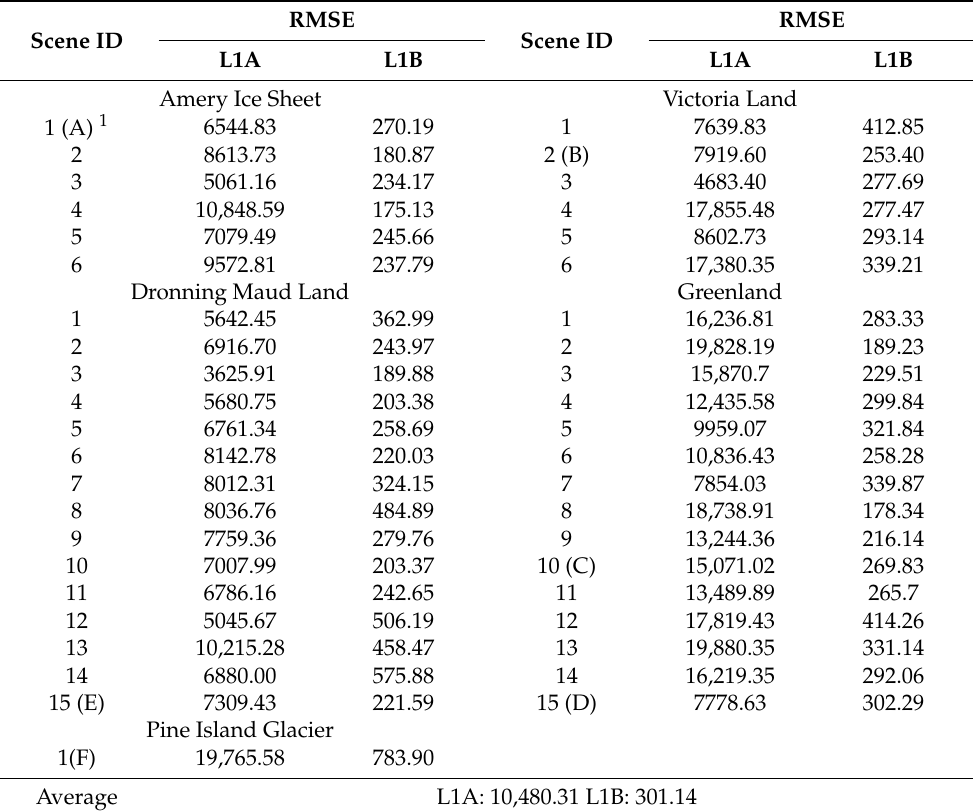
Table 1. Geolocation errors of the BNU-1 L1A/L1B product (unit: meter).